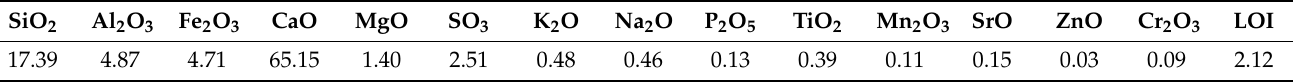
Table 2. Chemical composition of cement with bulk XRF (% weight).